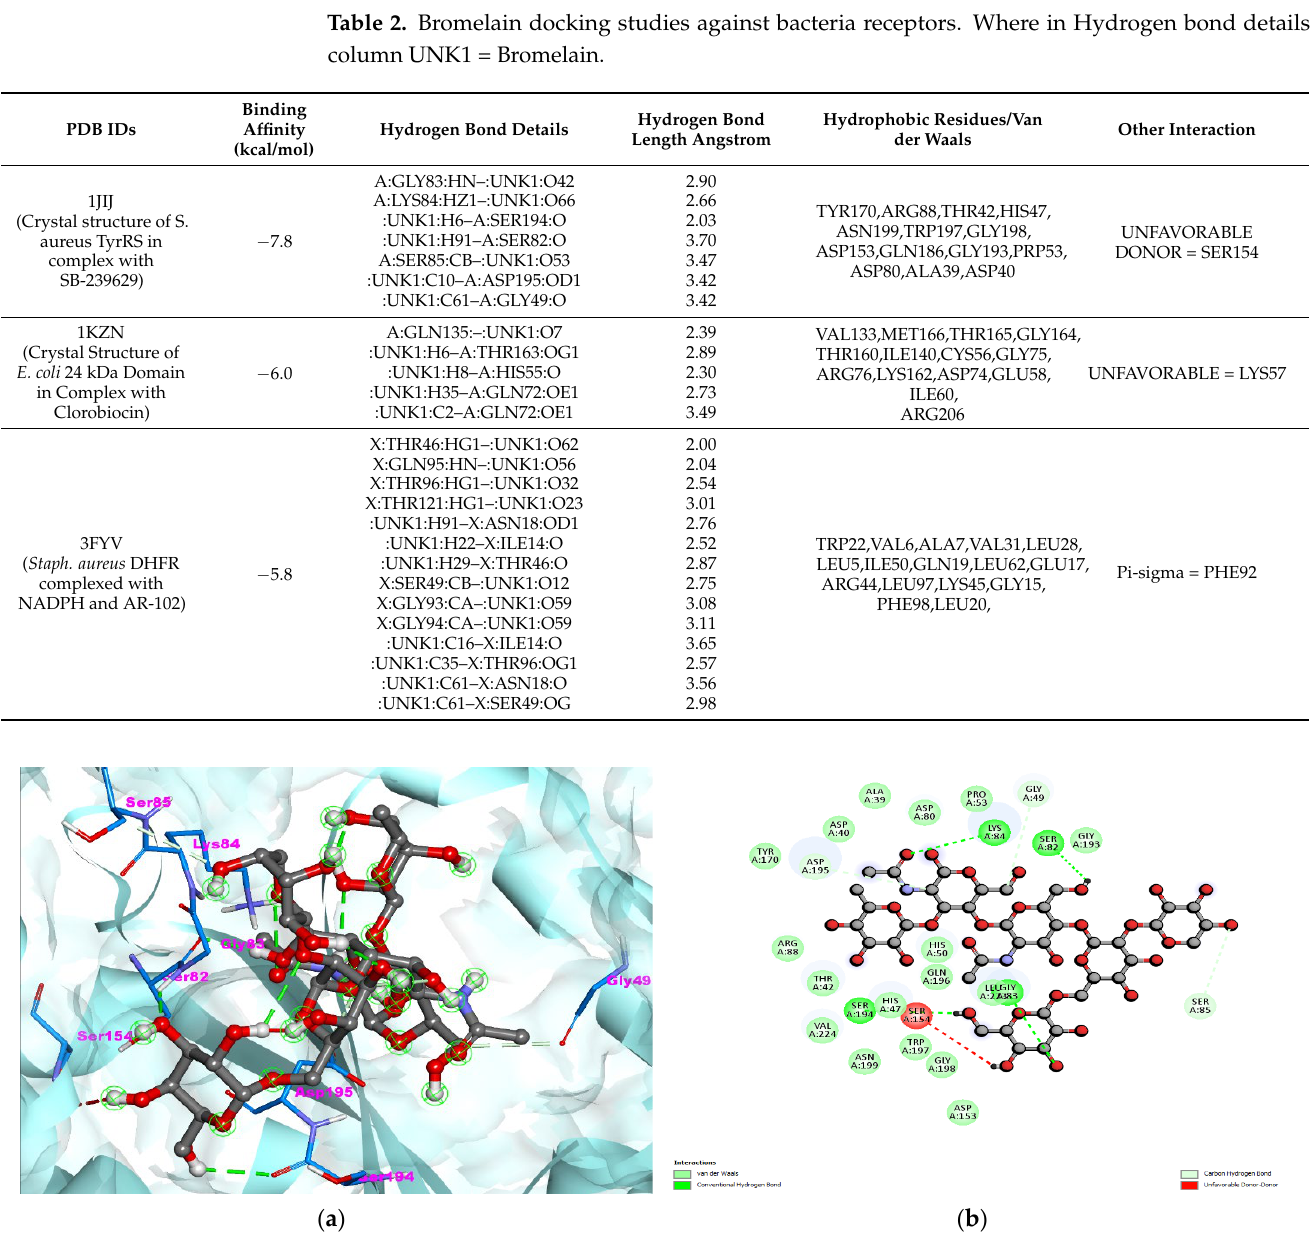
Figure 2. ( a ) 3D visualization of S. aureus TyrRS- bromelain complex. The light-turquoise color ribbon pattern shows S. aureus TyrRS (PDB:1JIJ) and the bromelain is shown in grey color with ball stick pattern in the center. ( b ) 2D visualization of interaction.